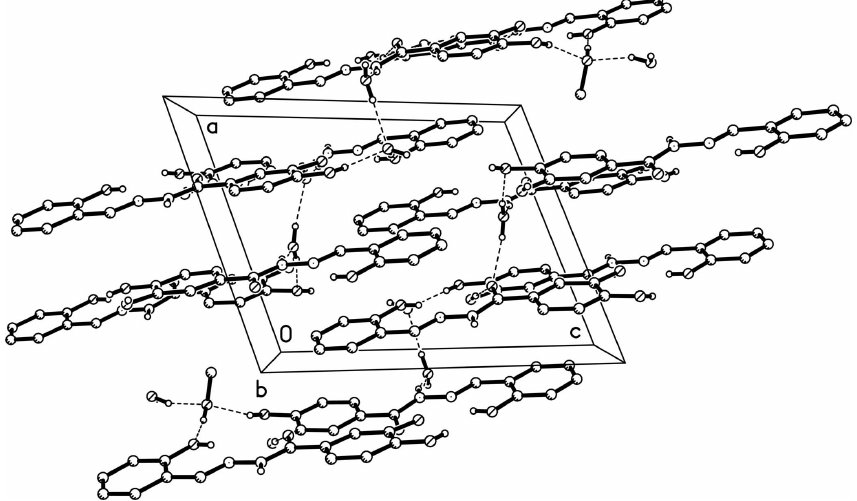
The asymmetric unit of the title compound. Displacement ellipsoids are drawn at the 30% probability level.